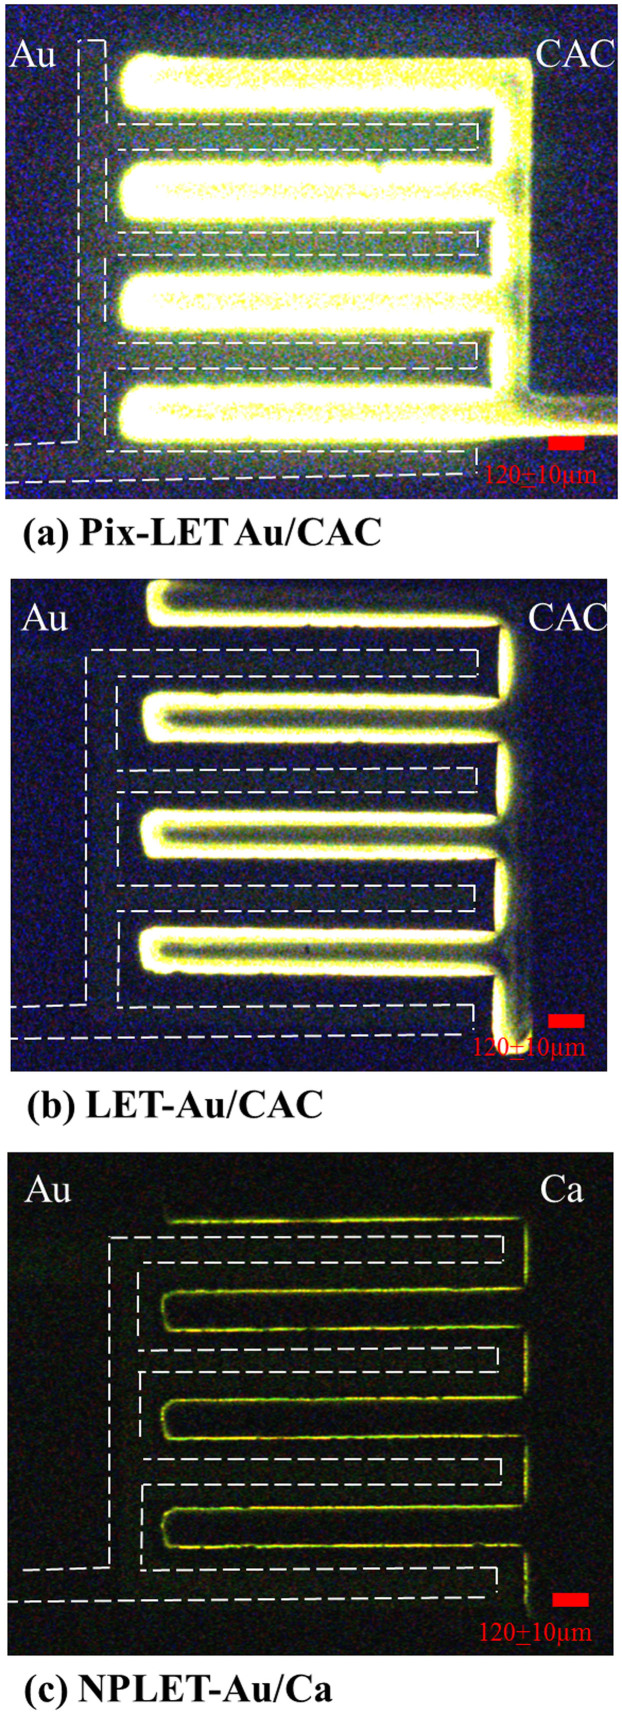
Emission at Vg = −150 V and Vds = −150 V, in (a) Pix-LET, (b) NPLET-Au/Ca, and (c) LET-Au/CAC.